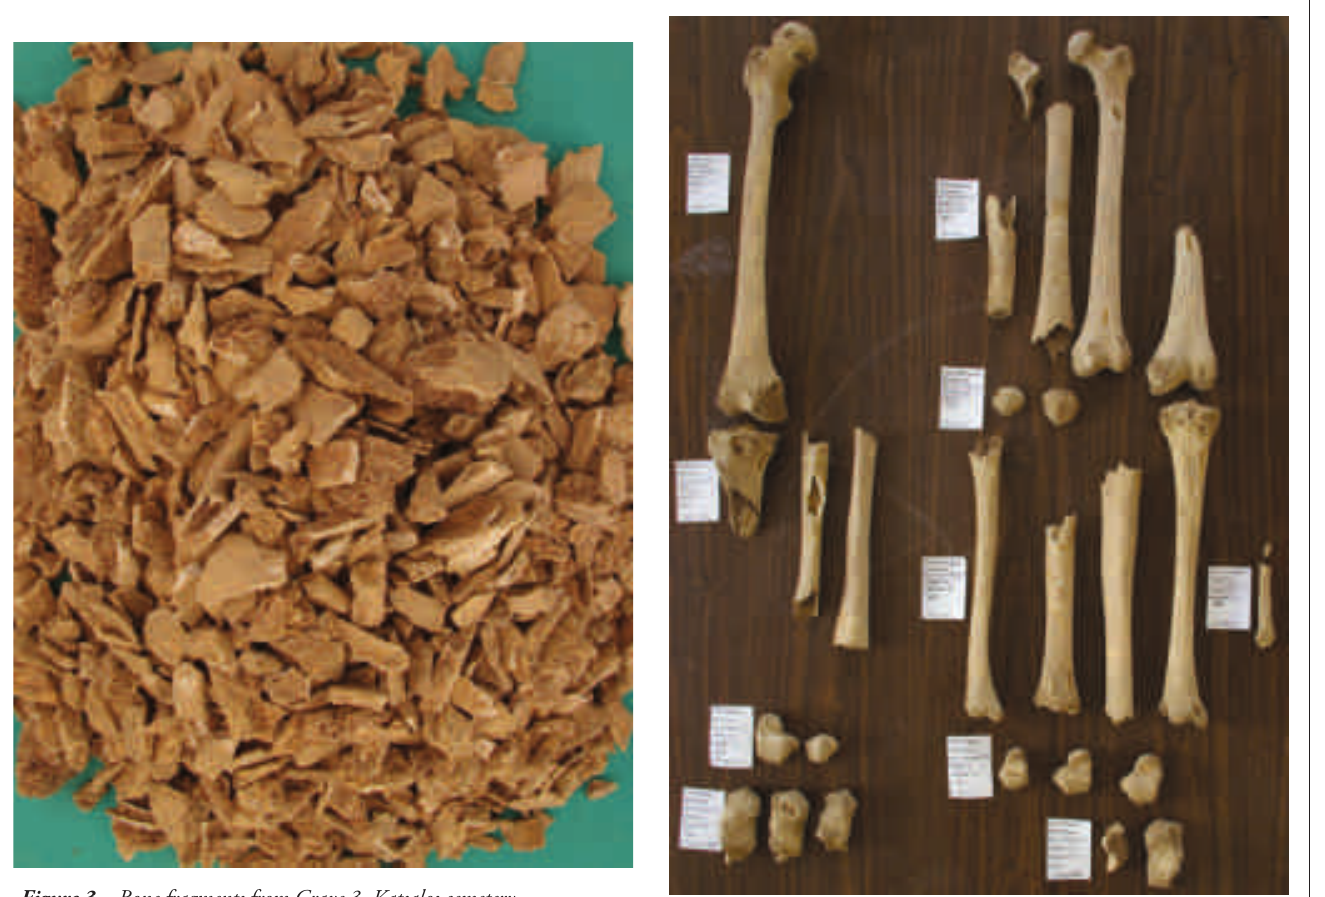
Figure 3 Bone fragments from Grave 3, Katsalos cemetery